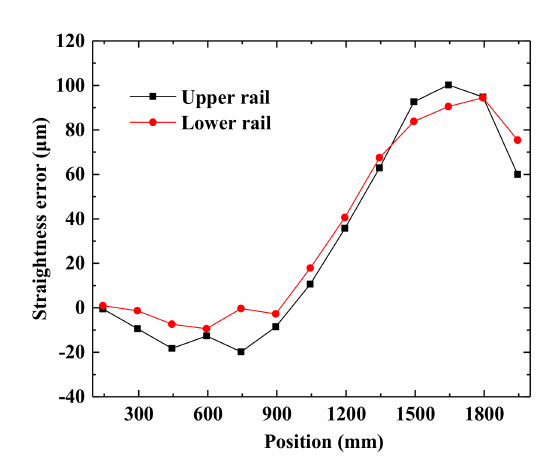
Figure 5. Straightness error in Z direction of two